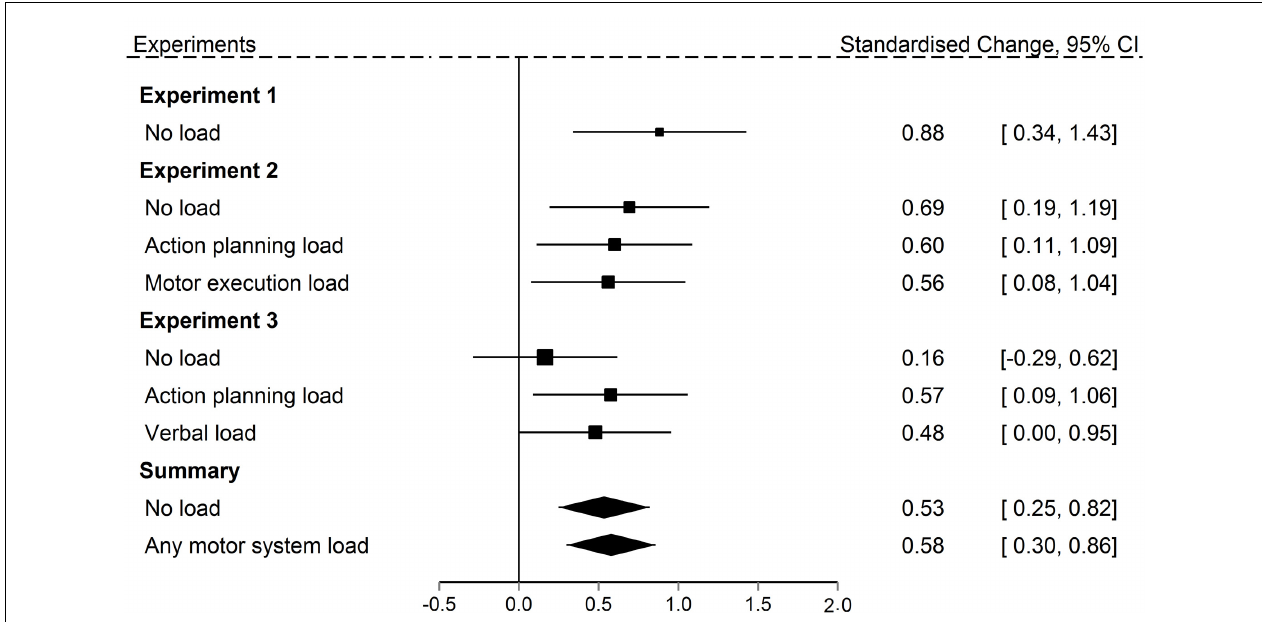
FIGURE 8 | Standardized mean change between observed and predicted source errors committed in the Recall own task in Experiments 1 through 3 for all concurrent load conditions. Size of the squares represents the weights of the individual comparisons. The error bars are 95% confidence interval. The polygons represent the summary effects (fixed effects) of the No load conditions and the Motor system load conditions (Action planning load and Motor execution load).